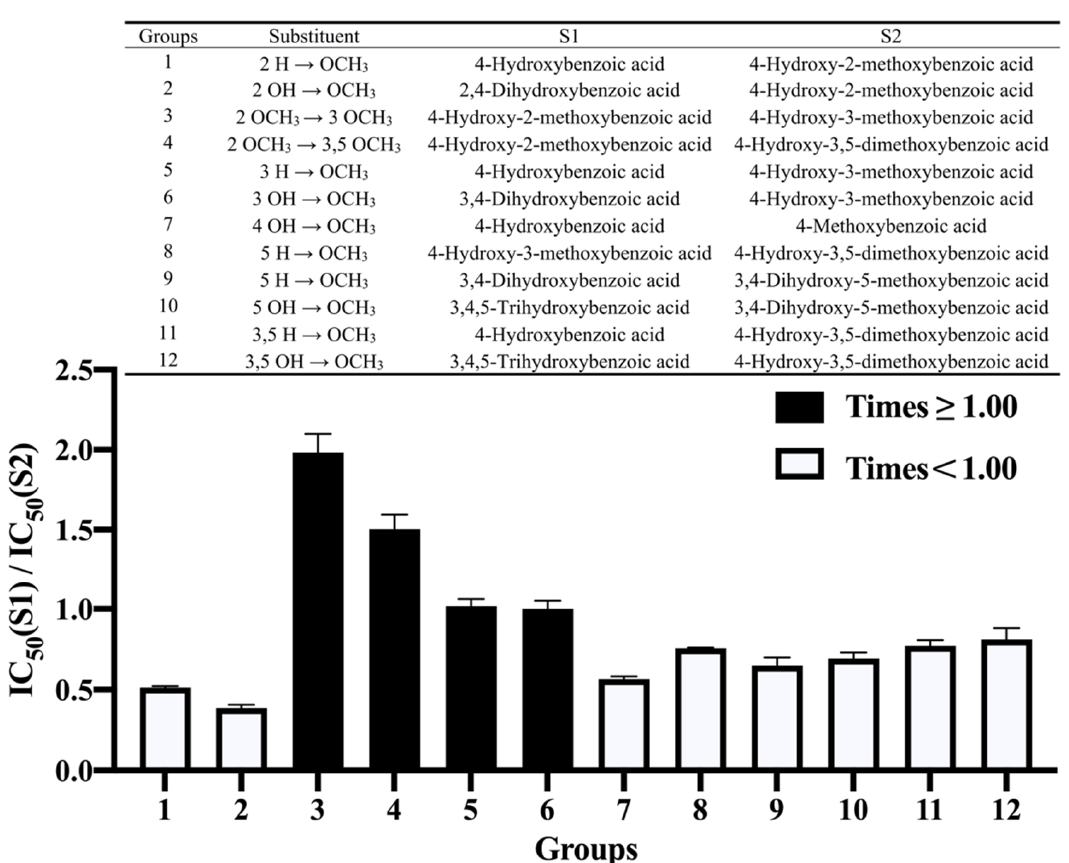
Figure 2. The effect of methoxylation on the benzene ring on the inhibition of α -amylase by benzoic acid and its derivatives. S1—Structure 1; S2—Structure 2. acid and its derivatives. S1—Structure 1; S2—Structure